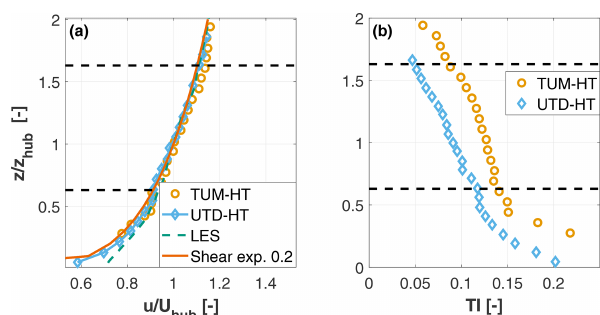
Figure 7. Inflow velocity profiles (a) and turbulence intensity pro- files (b) for TUM-HT and UTD-HT inflow conditions; black dashed lines denote the rotor